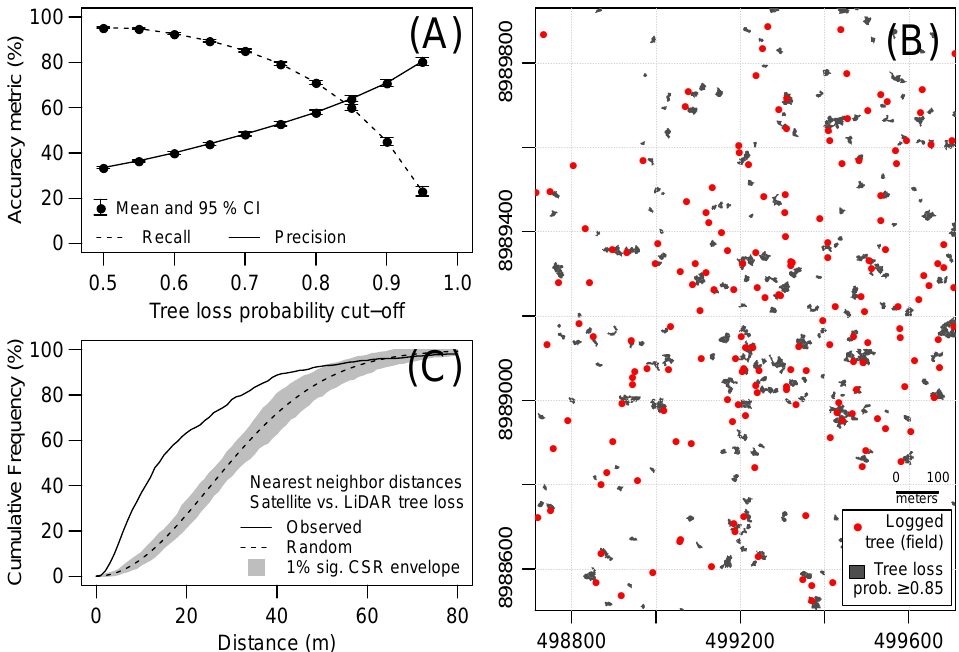
Figure 4. Tree loss detection using VHR satellite data and RF model in the Jamari National Forest over the UPA-06. ( A ) Detection accuracy as a function of the tree loss probability cut-off. ( B ) Satellite-based tree loss map considering a tree loss probability ≥ 0.85 (UTM, datum WGS-84). ( C ) Nearest neighbor distances between satellite and LiDAR tree loss detections, as a function of distance (m). The gray area represents a CSR envelope with a 1% significance level ( n =